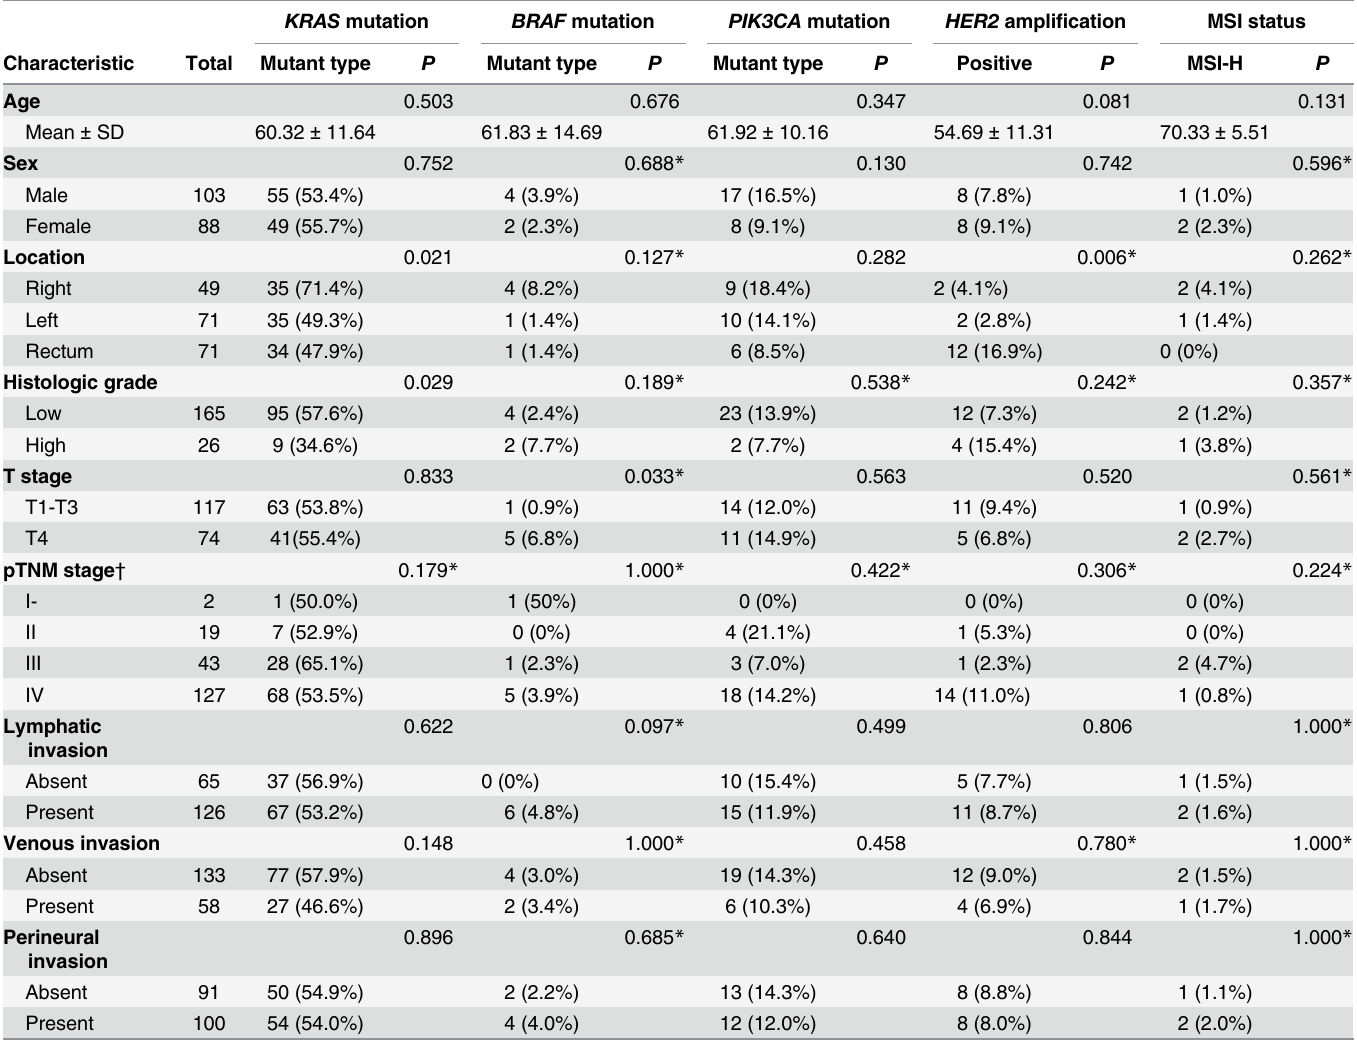
Table 3. Clinicopathologic characteristics according to mutational status of each